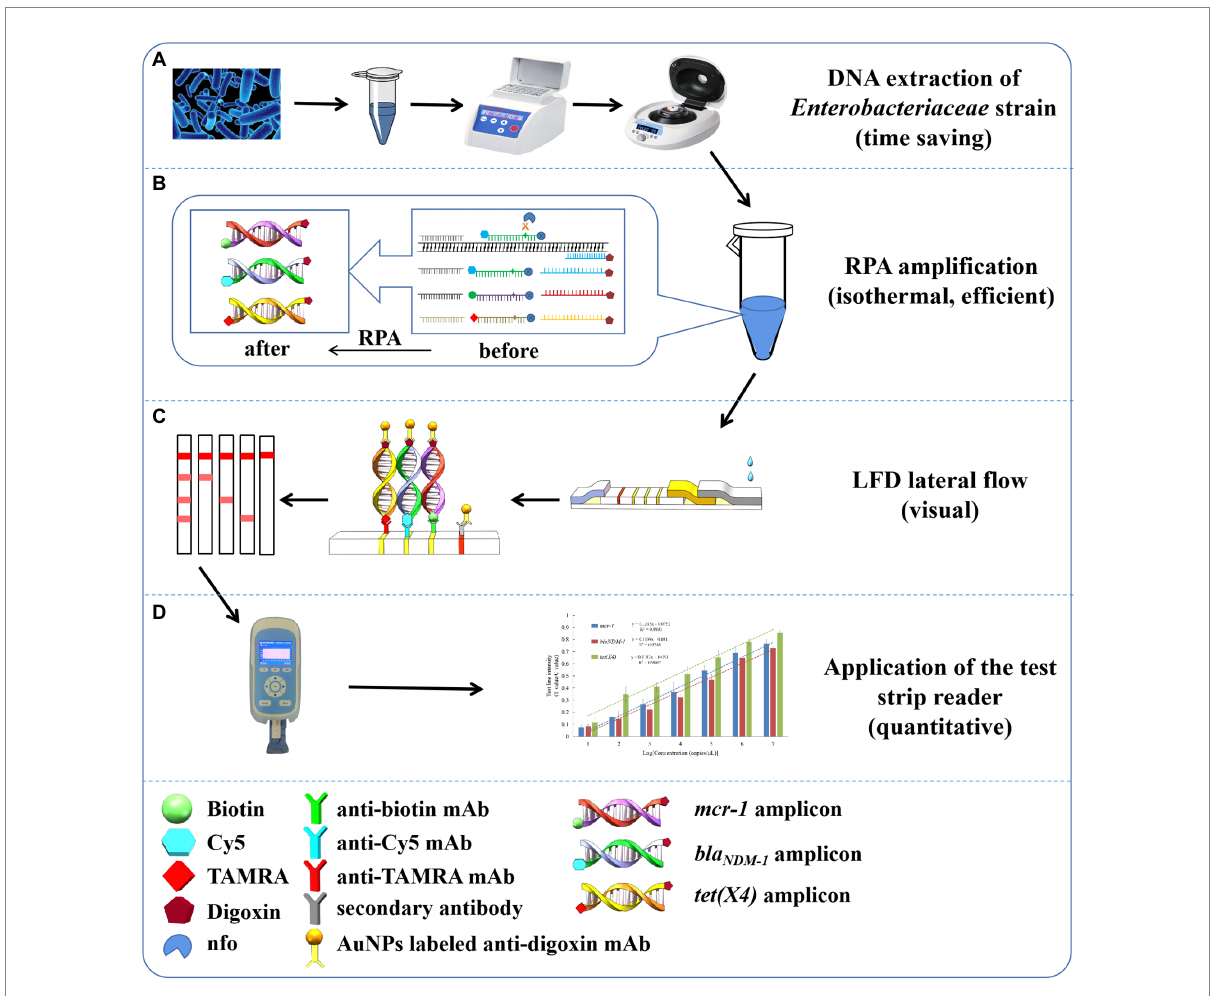
FIGURE 1 RPA-LFD assay strategy. (A) DNA extraction of Enterobacteriaceae strains; (B) RPA amplification; (C) LFD lateral flow; (D) quantitative